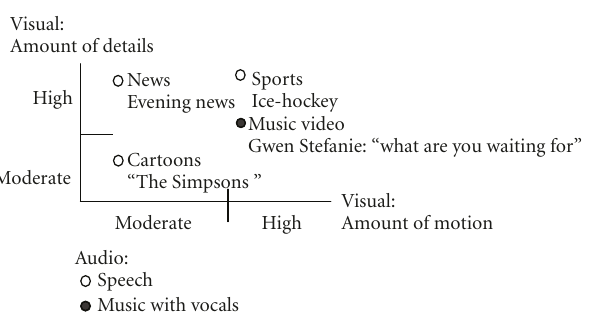
Figure 6: Genre of stimuli sequences, contents, and their audio- visual characteristics.